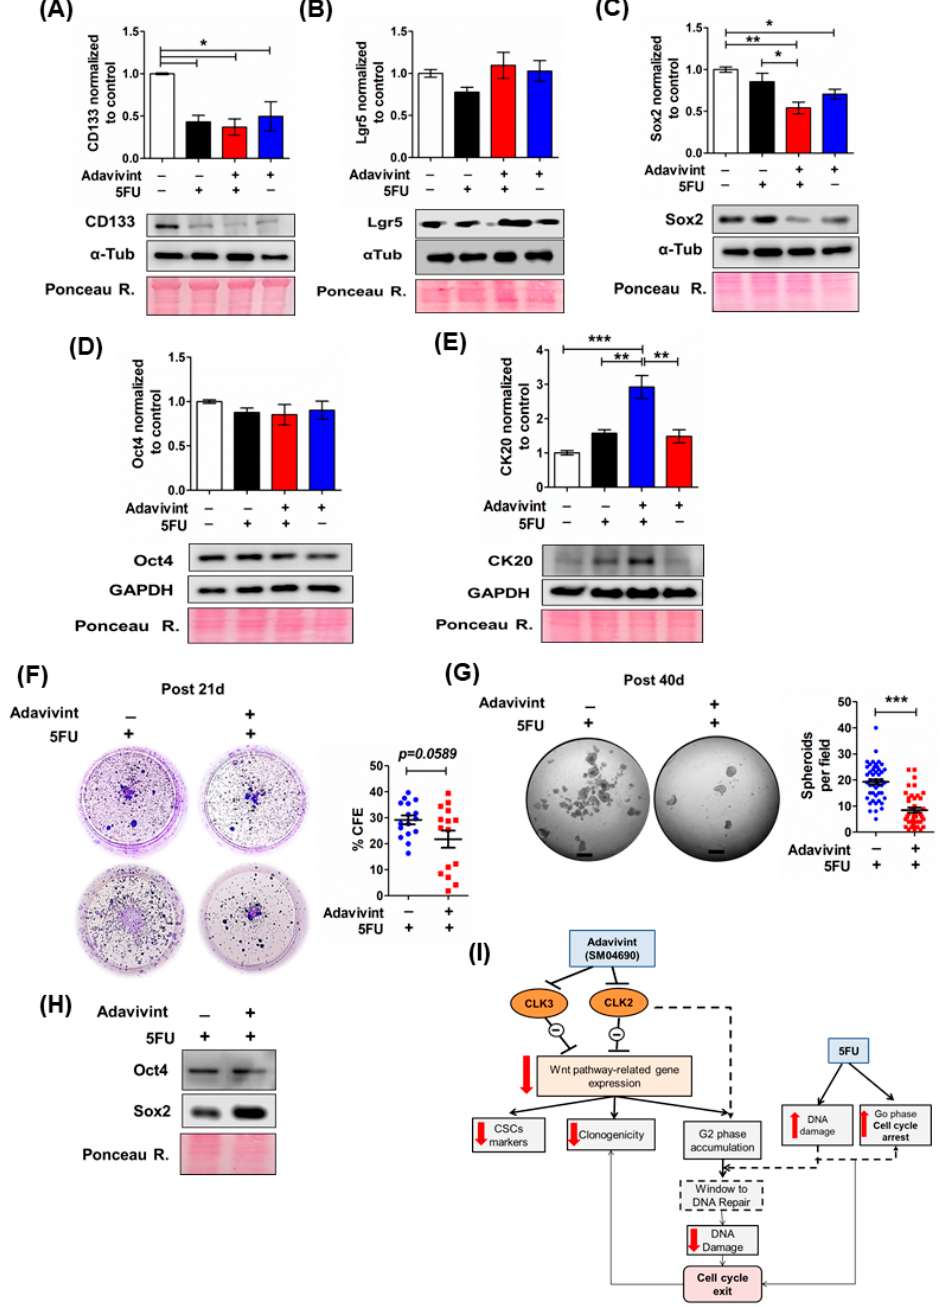
Figure 7. Adavivint Wnt inhibitor reduces clonogenicity and cancer stem-marker expression in SW620 spheroids. ( A – D ) Representative immunoblots of cancer stem cell markers CD133 ( A ), Lgr5 ( B ), Sox2 ( C ), and Oct4 ( D ) of SW620 spheroids treated with or without Adavivint for 72